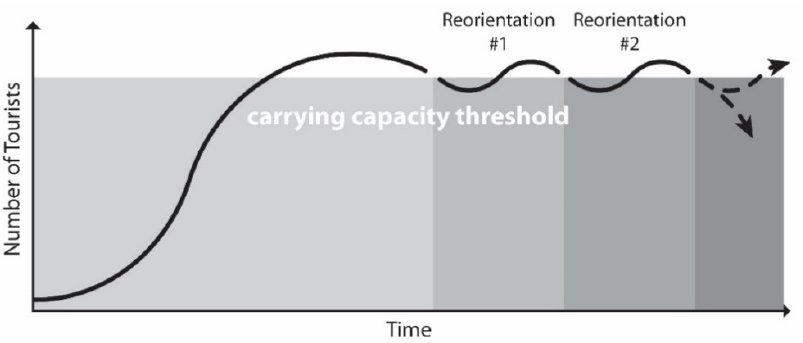
Figure 2. TALC model considering Agarwal’s reorientation phases. Graphic by author, adapted from Agarwal,